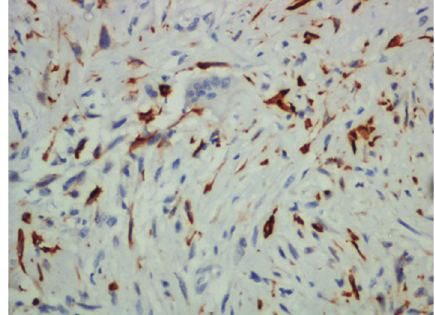
Figure 2: High power view showing bizarre spindle-shaped tumor cells along with osteoclastic giant cells (H&E, 400x).